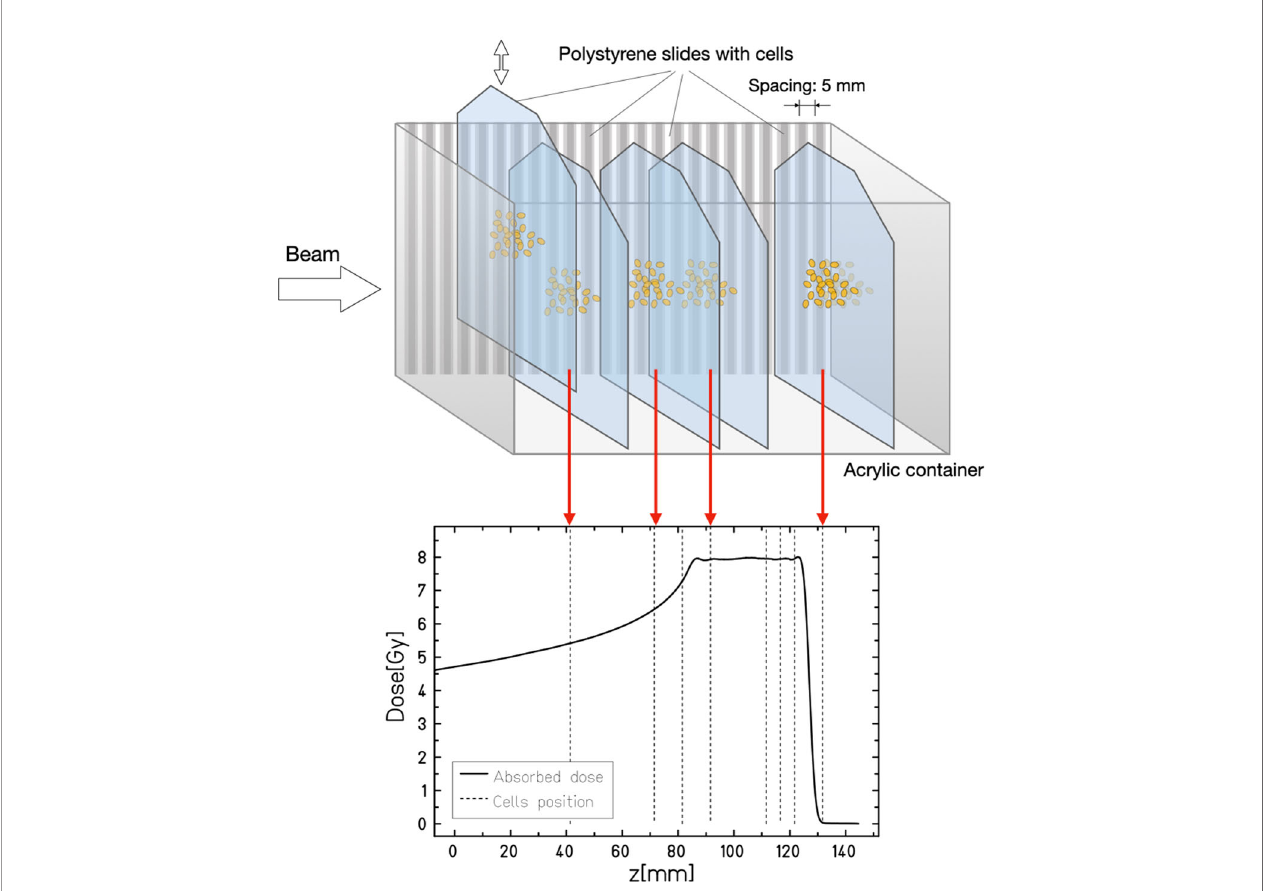
FIGURE 8 | Cellular phantom used for radiobiological measurements along a SOBP. The cells grow in monolayer on plastic plates that can be plunged at different position in the tank fi lled with water-equivalent growth medium. Plates are then removed after irradiation and the cell survival is measured in every position. In the BARB experiment, stable and radioactive carbon and oxygen isotopes will be used to irradiate CHO cells, under the null-hypothesis that no difference will be